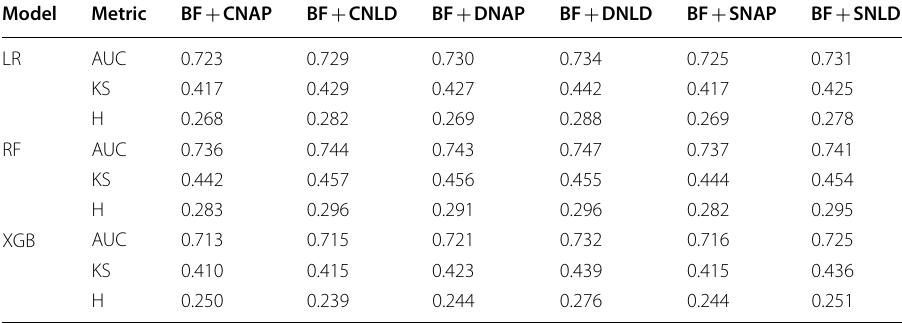
Table 5 Discrimination performance of relational risk in relationship-specific and risk event–specific